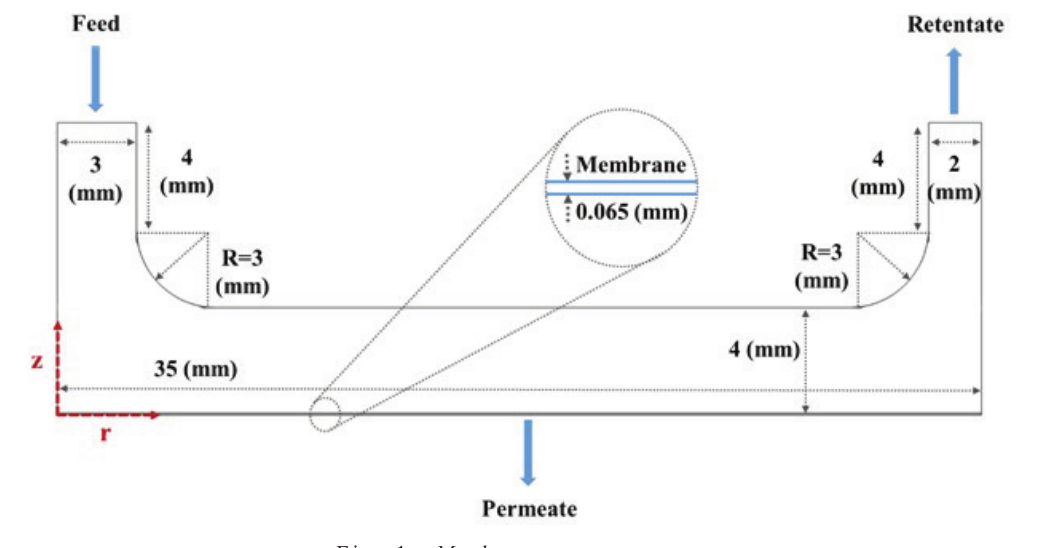
Fig. 1 – Membrane system